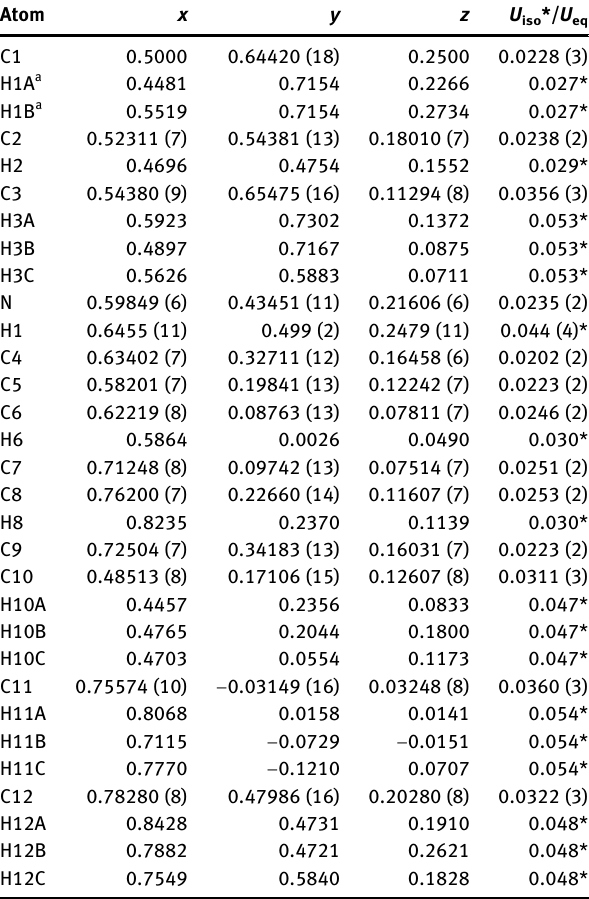
isotropic displacement parameters (Å 